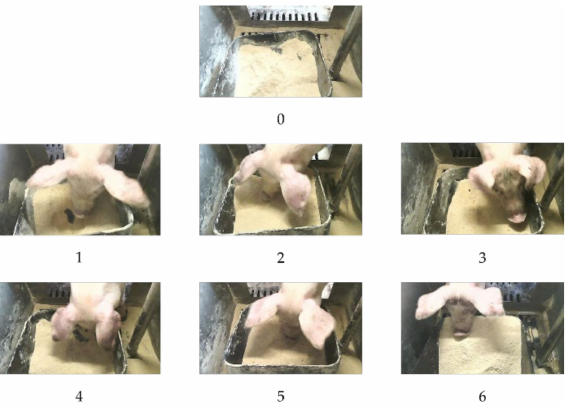
Figure 5. Images of individual pigs at FARS. Nonfeeding ( 0 ); numbers of feeding pigs ( 1 ~ 6 ). Compared with the images caught by FARS, the images caught by DARS (Figure 6, 1280 × 720 pixels) had little useless information and only needed to be marked and cleaned. After cleaning, the original 21,920 images were reduced to 11,298. The marked images are shown in Figure 6: six pigs that were drinking water were marked from 1 to 6. Images with no drinking were marked as 0.